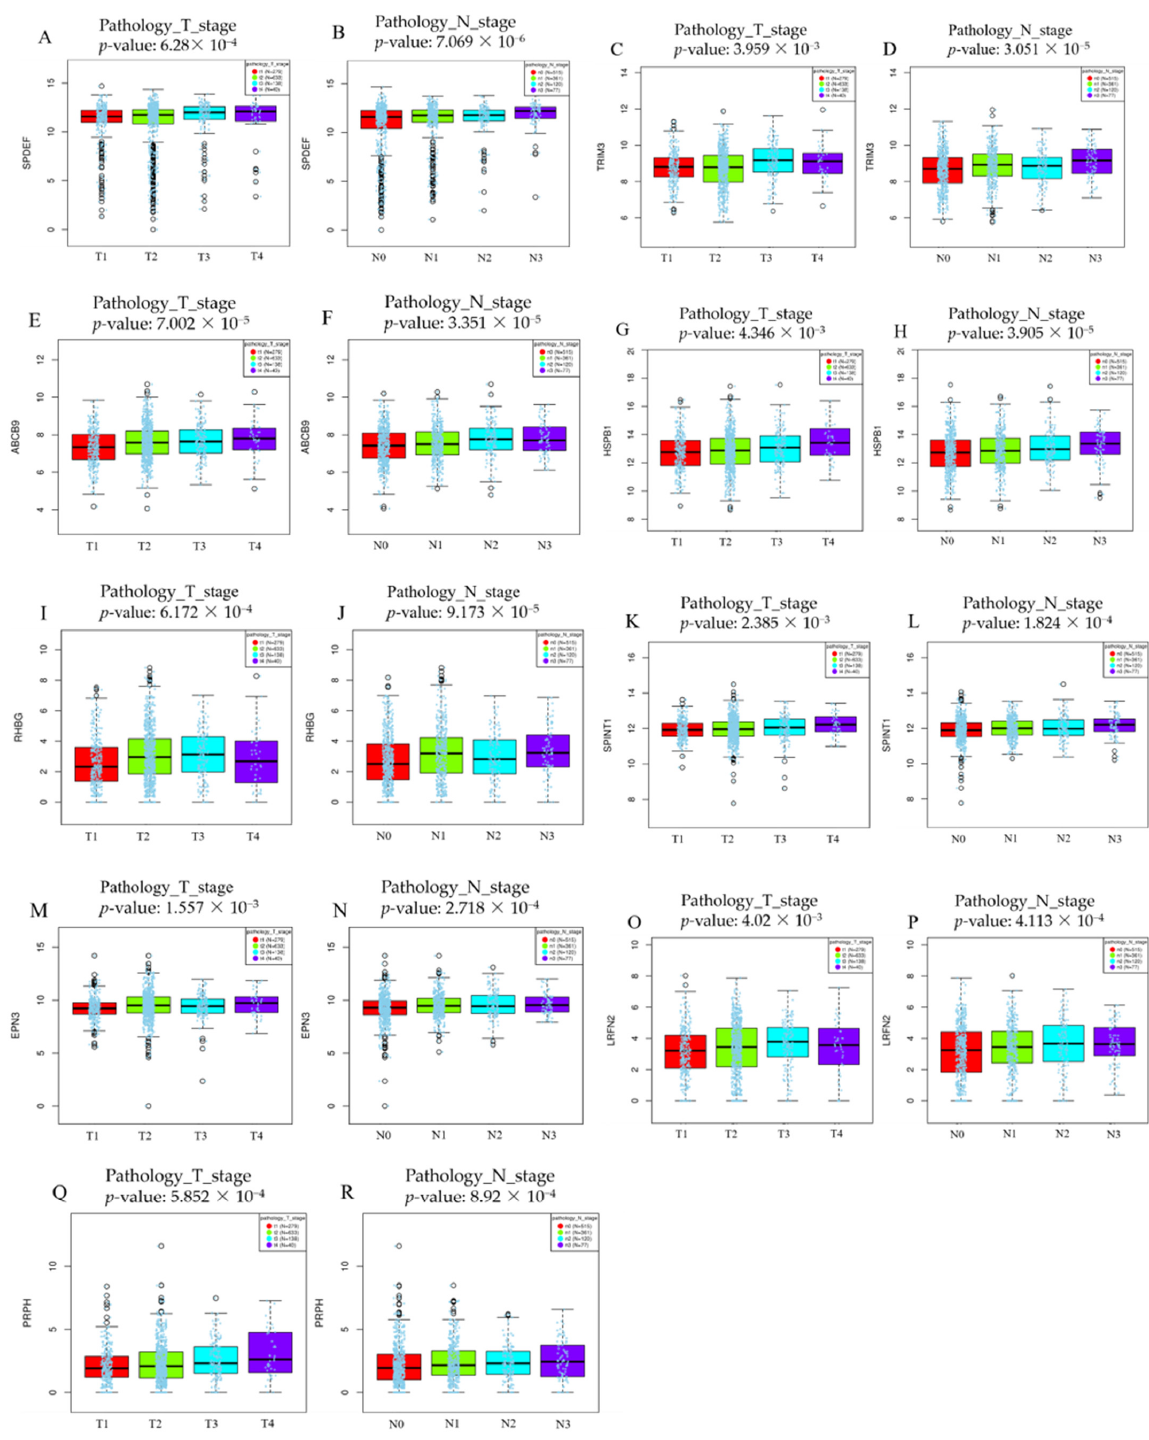
Figure 3. Box plot showing stepwise expression of nine genes in each T and N stage using LinkedOmics (Jonckheere trend test). As the stage progresses, the expression level also increases. ( A ) SPDEF (pathology_T_stage), ( B ) SPDEF (pathology_N_stage), ( C ) TRIM3 (pathology_T_stage), ( D )